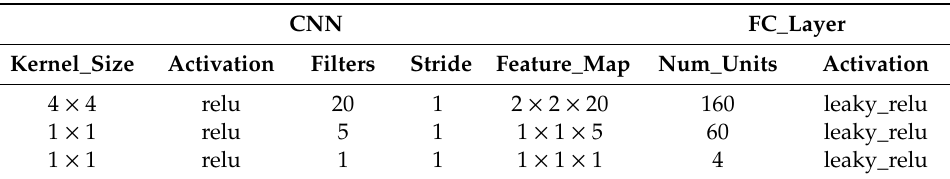
Table 1. Parameter setting of FMS-Net